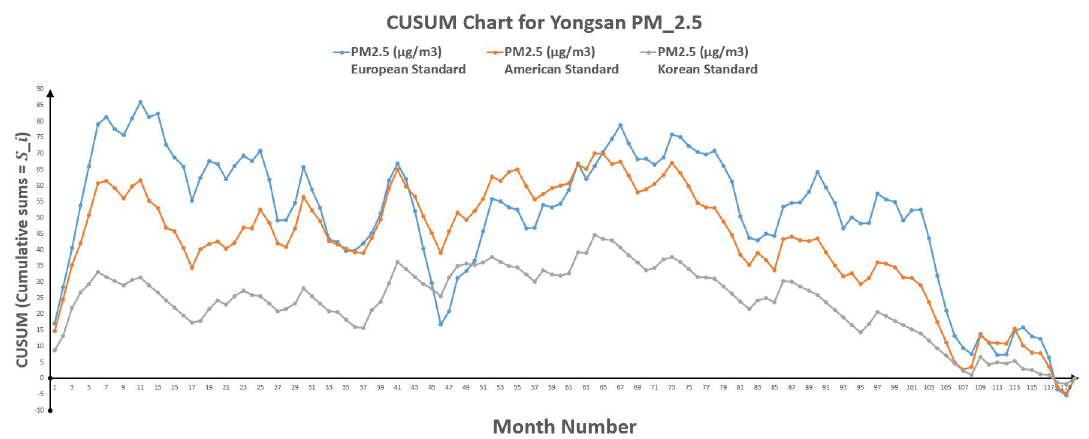
Figure 8. CUSUM chart for Yongsan PM 2.5 .